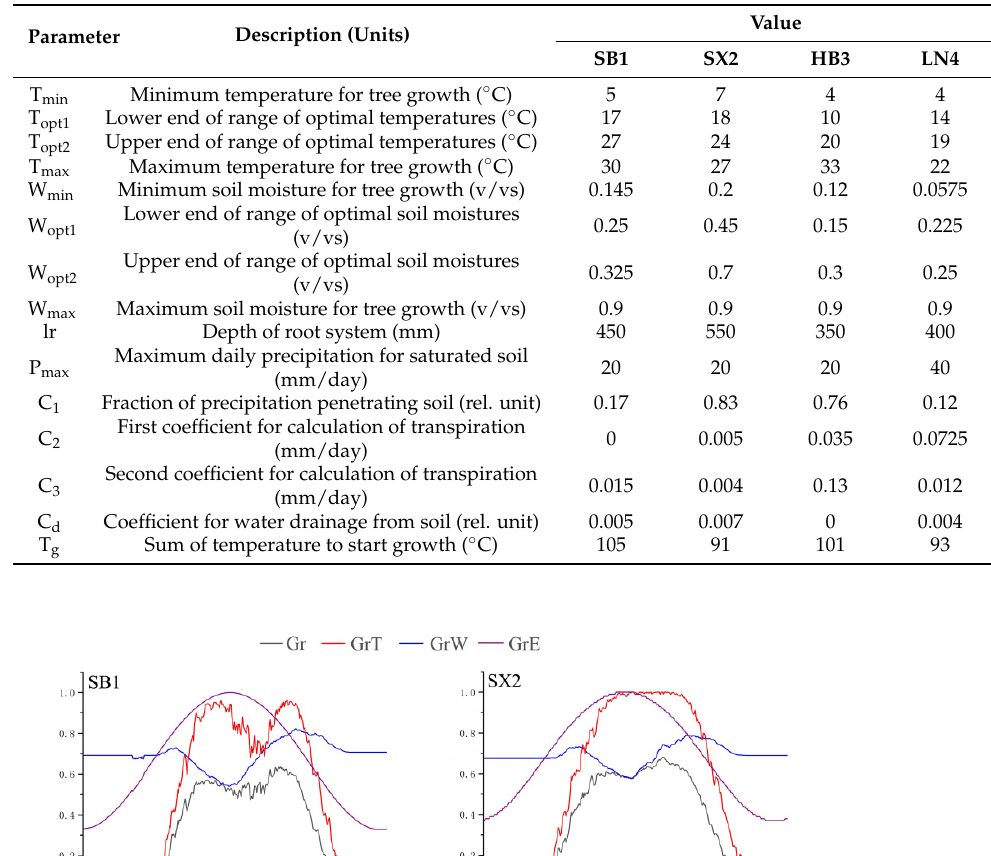
Table 1. Model parameters for the simulated tree radial growth of the four sites.